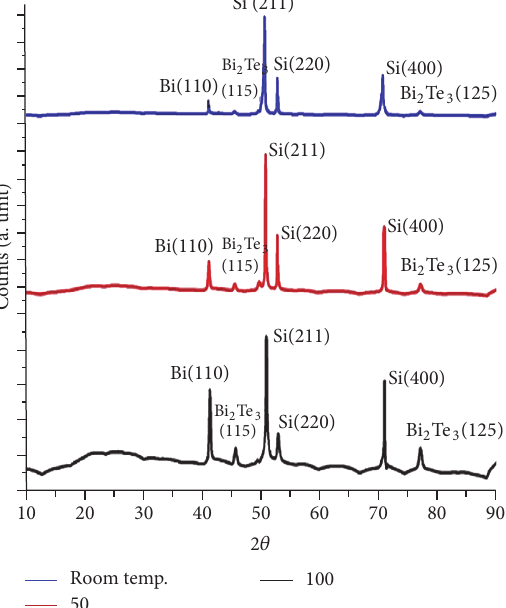
Figure 3: XRD for thickness of 500 nm at room temperature, annealed at 50 ∘ C and 100 ∘ C.